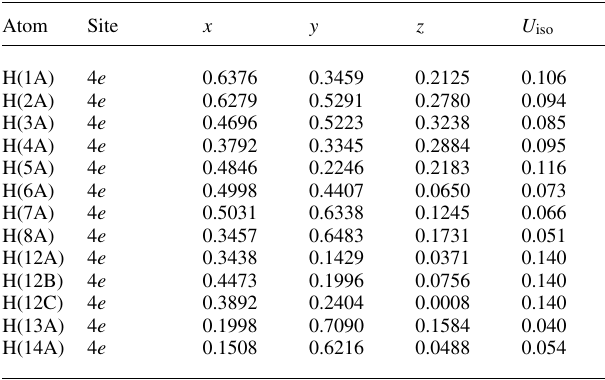
Table 2. Atomic coordinates and displacement parameters (in Å 2 )